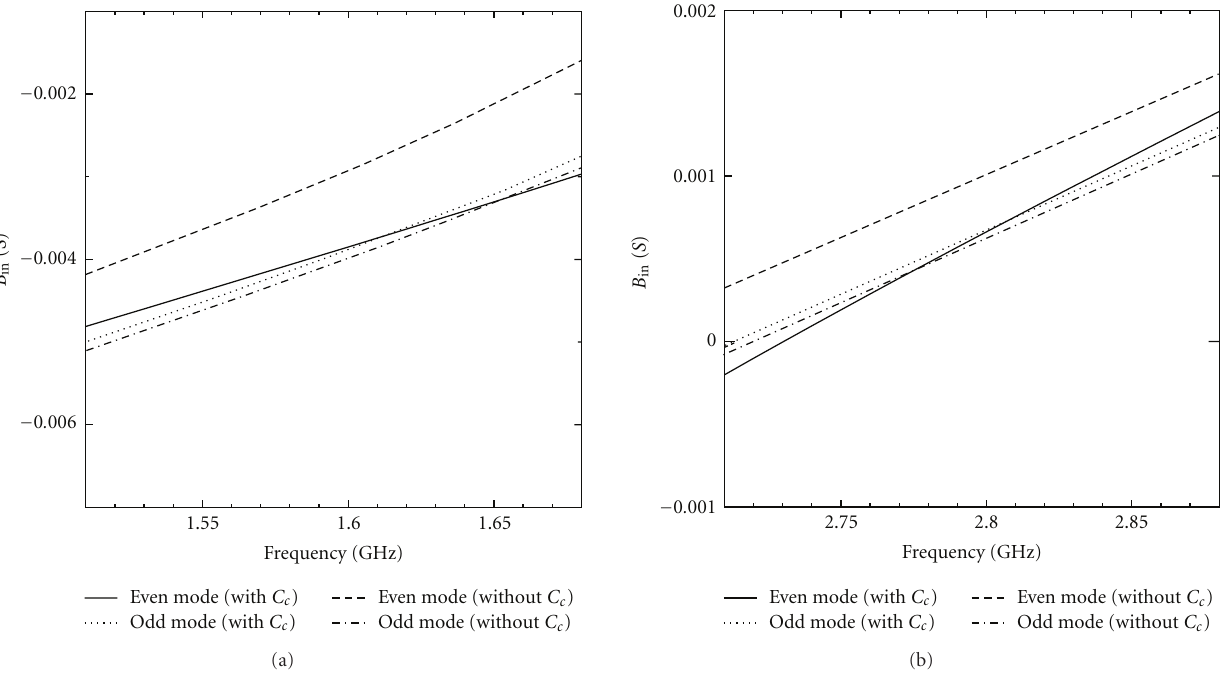
Figure 5: Frequency characteristics of input susceptances around attenuation-pole frequencies (a) below and (b) above passband.